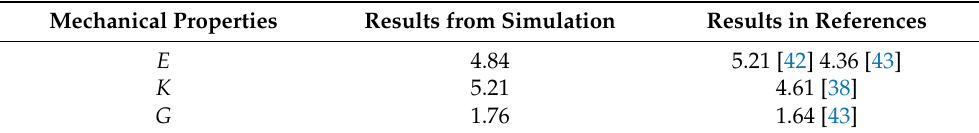
Table 3. Mechanical properties of models under different concentration of silica (units: